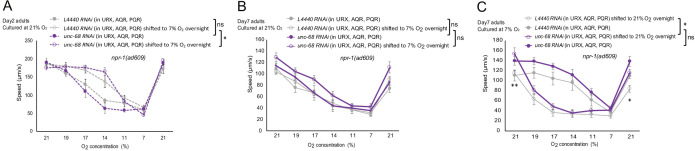
O2-evoked speed responses of animals with unc-68 cell-specific knockdown in O2-sensing neurons.Mean ±sem, *p<0.05, **p<0.01 asterisks above the speed plot indicate a significant interaction between the effect of gene knockdown and [O2] steps on speed responses, asterisks next to the data point in the plot indicate a significant difference of speed at this [O2] point compared to either RNAi feeding or control animals experienced the same O2 culture condition.